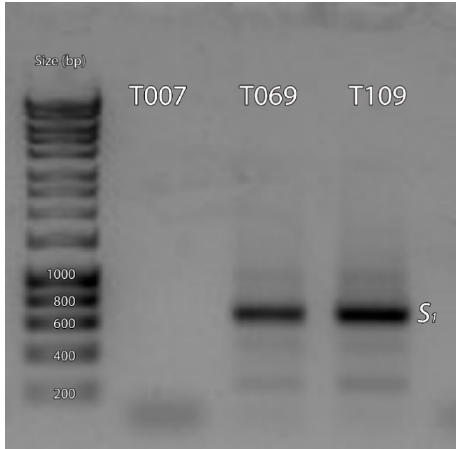
Figure 2. PCR amplification of the RNase second intron region using the specific primers SHLM1 and